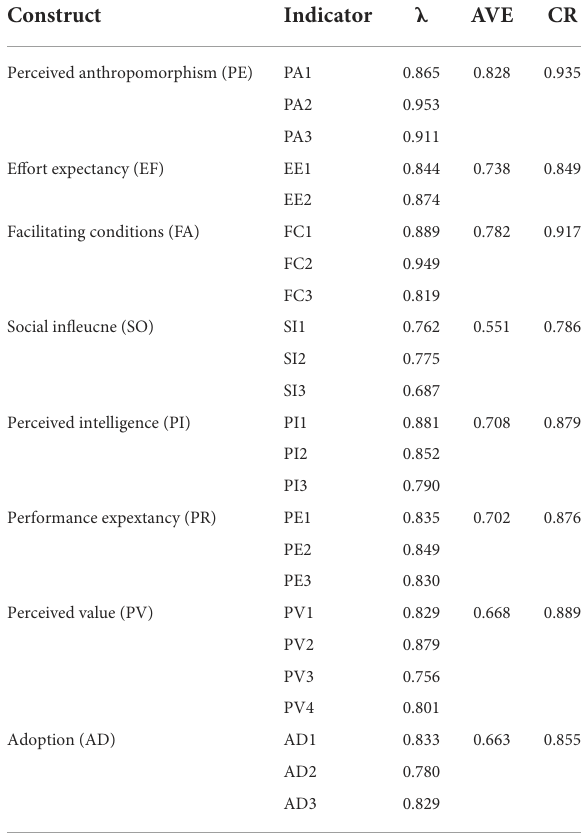
TABLE 2 Demographic information. TABLE 3 Confirmatory factor analysis